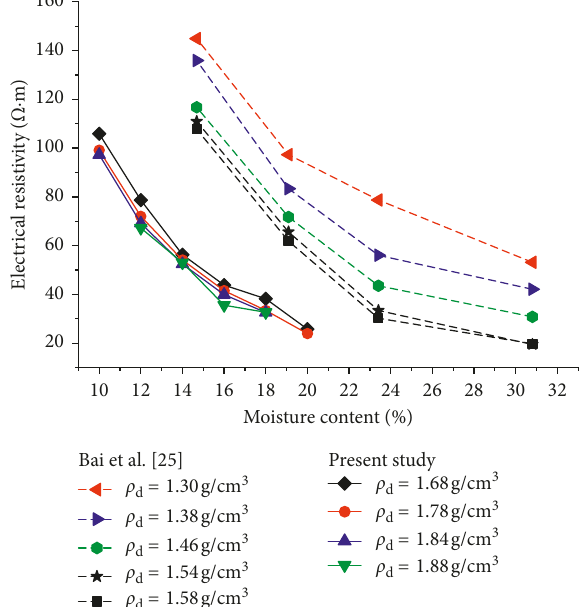
Figure 7: Variations of electrical resistivity with moisture content and degree of compaction.